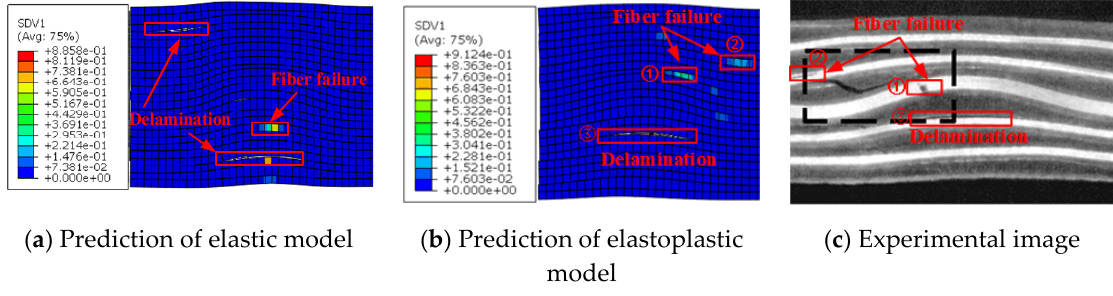
Figure 18. Damage locations for a specimen with wrinkle level 11.4° ( a ) predicted by the elastic model, ( b ) predicted by the proposed elastoplastic model, and ( c ) test image [10].